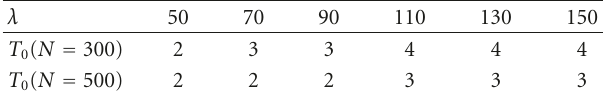
Table 2: T 0 , the forwarding bound, used in Tests 1 and